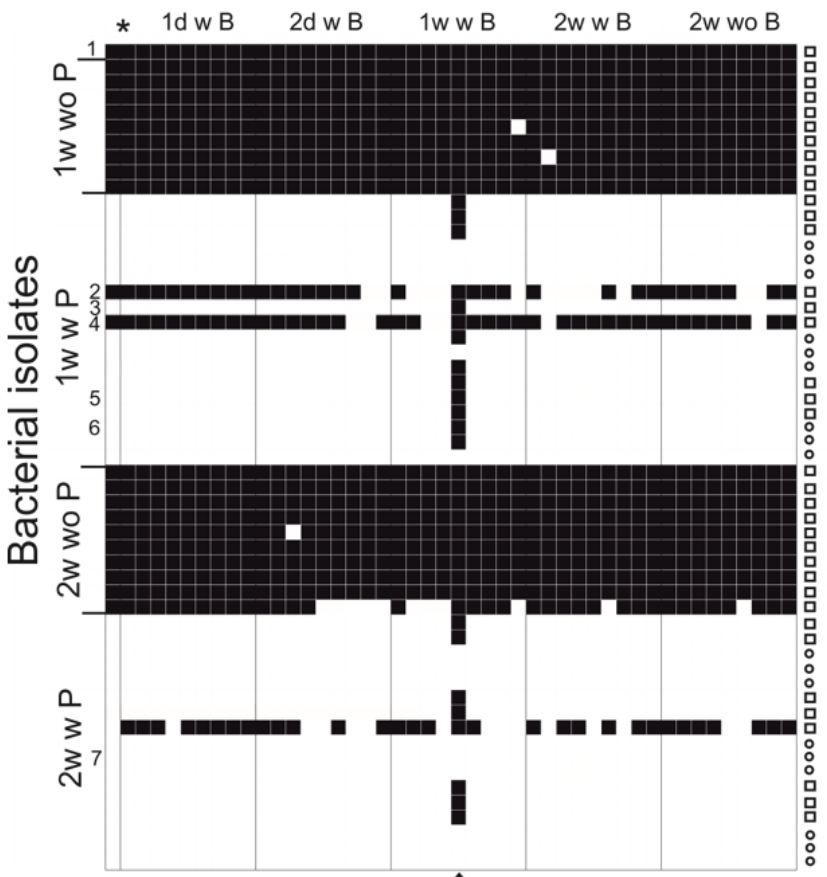
Figure 3. Infectivity of the ancestral phage and phage isolates from one week and two weeks against the original bacteria and isolates from one week and two weeks. Black squares indicate infection and white squares indicate no infection. Colony morphology of the bacterial isolate is indicated on the right, where a square indicates rhizoid and a circle indicates rough. * = Ancestral phage. Numbers correspond the strains in Table 1 (1 being the ancestral strain B245). An arrow at the bottom indicates the evolved phage FCV-1.01. B = bacteria, P = phage, w = with, wo = without. One phage isolate differed from other phage isolates by being able to infect 41 out of the 55 tested bacterial isolates, whereas the other phage isolates from the experiment infected approximately 20 out of 55 isolates. In addition, the evolved phage was able to infect 18 out of the